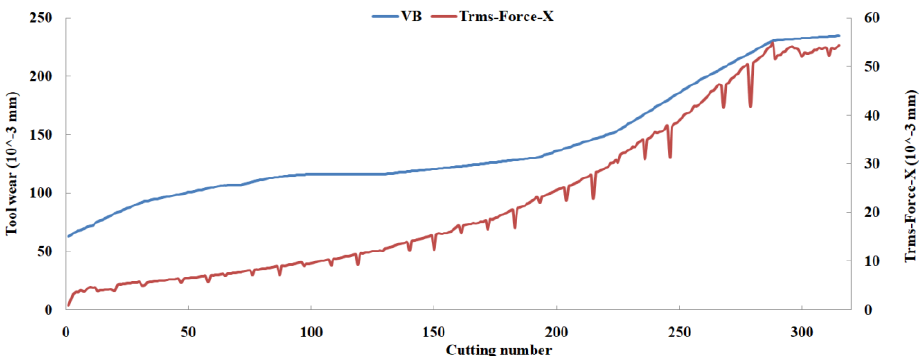
Figure 8. The scatter diagram between T rms in X-dimension Force and tool wear value.